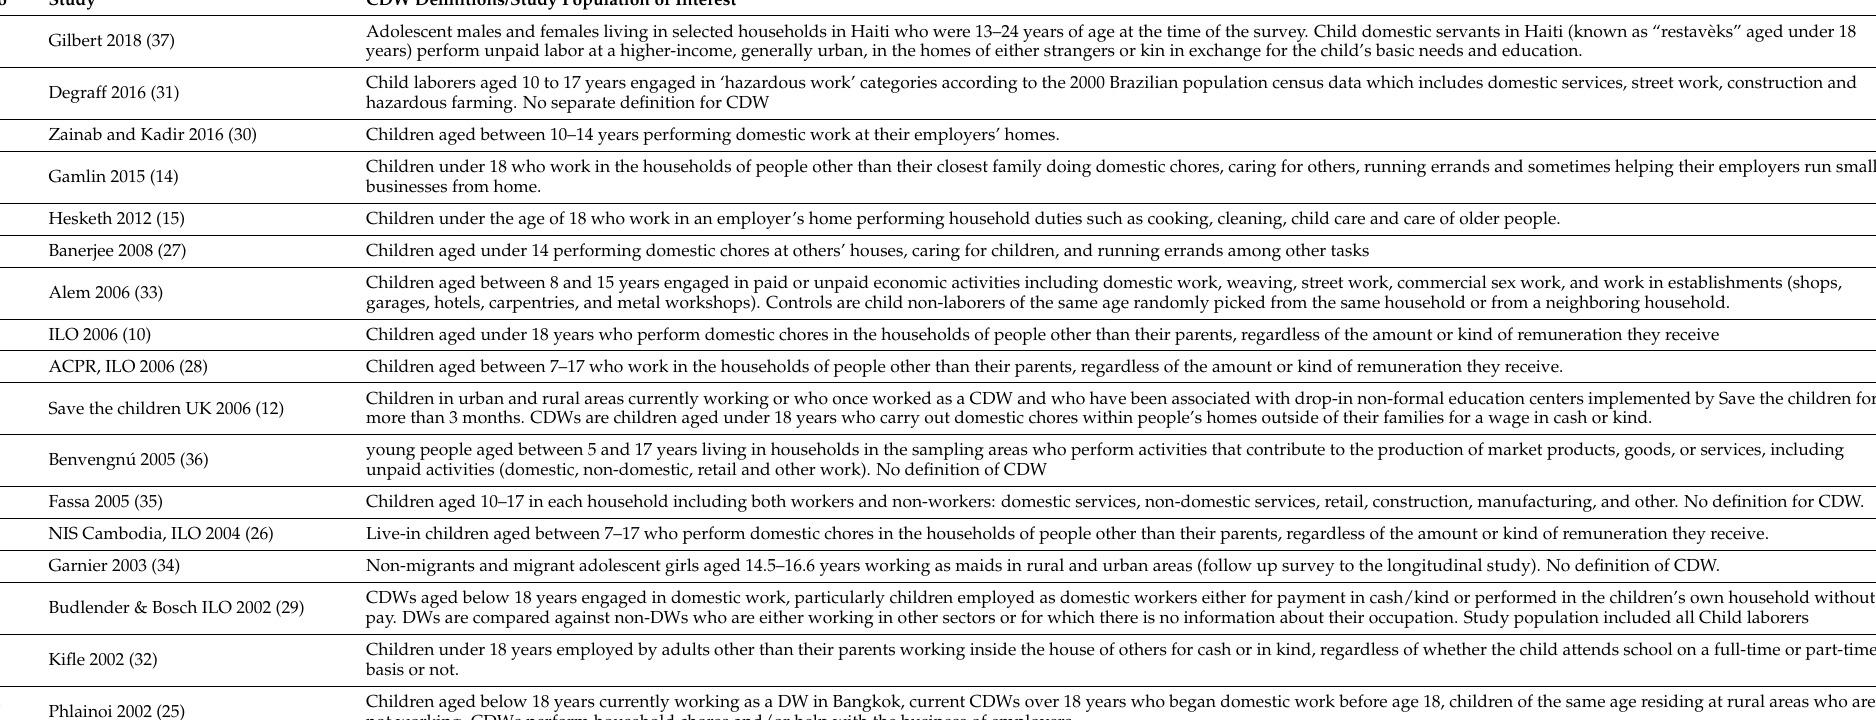
Table A4. Study populations as defined in the included